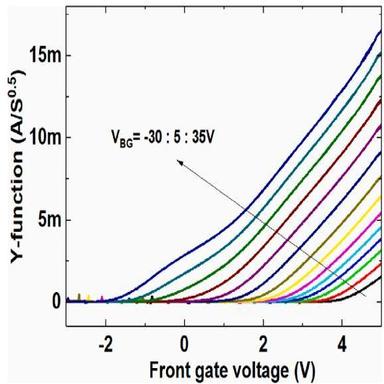
Y-function for various back gate voltages as seen from the front-gate for N + source/drain and P + Poly-Si gate.